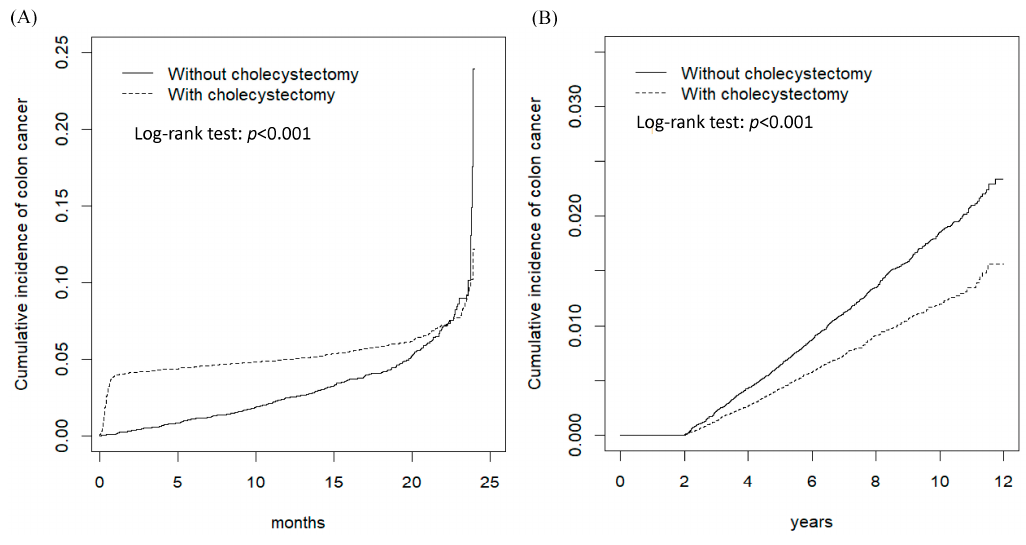
Table 2. The comparison of the colon cancer incidence densities within the first 6 months of the follow- up period between gallbladder stones patients with and without cholecystectomy, based on the stratification of demographic characteristics and the presence or absence of a comorbidity.